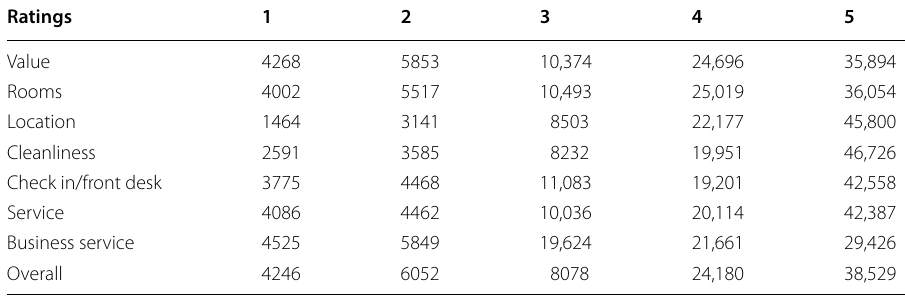
Table 2 TripAdvisor dataset ratings distribution